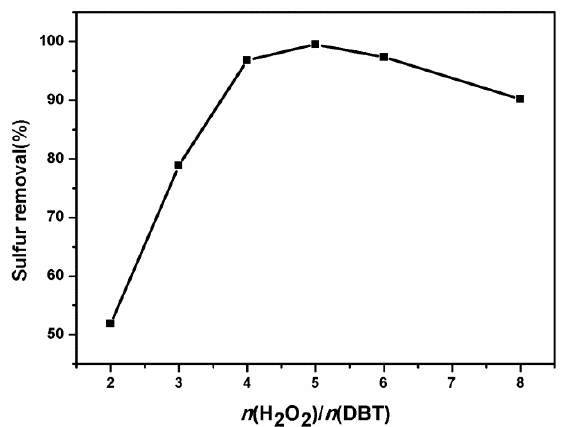
Figure 5. Influence of the H 2 O 2 /DBT molar ratio on the oxidative desulfurization of DBT. Conditions: Model oil = 5 mL, n ([Bmim] 5 PMo 11 Co(H 2 O)O 39 ) = 4 μ mol, T = 50 °C for 60 min with [Omim]BF 4 (1 mL) as the extractant.